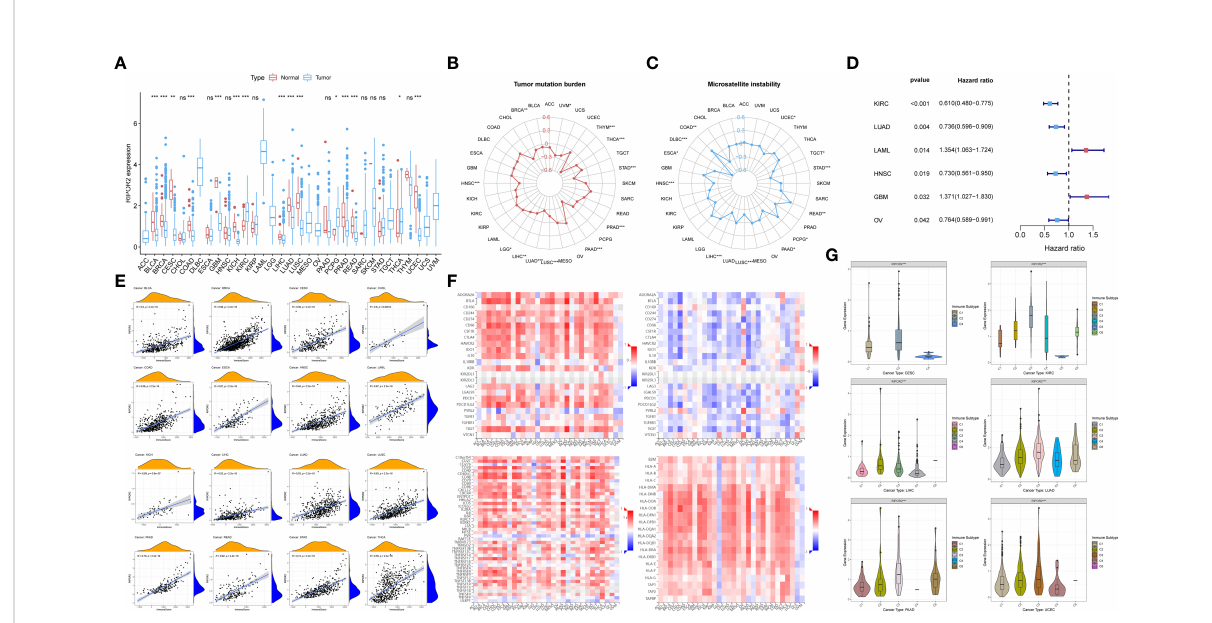
FIGURE 7 (A) The discrepant expression patterns of RIPOR2 in tumorous and normal samples were displayed (p-Value: *** p < 0.001, ** p < 0.01, * p < 0.05, ns p > 0.05). (B, C) The radar charts depicted the distributions of TMB (B) and microsatellite instability (MSI) (C) respectively. Corresponding to the circle representing value zero, the relative position of the points indicates the values of the index. (D) The forest plot showed the hazard ratios and p-values of how RIPOR2 affects the prognoses of various tumors. When RIPOR2 functions as a protective indicator, the pot gets drawn in blue when the risky factor is red. (E) We showed the results of correlation analyses in dot plots with R and p-values. The orange hill represents the distribution of immune-score and the blue hill of RIPOR2 expression. The positiveness of the relations can be seen from the rising fi tting line. (F) The grid heatmaps show the relations between RIPOR2 and ICPs with different functions in immune response, inhibitory ICPs on the top-left and the sub- fi gure on the top-right, in contrast with the association between the expression of methylated RIPOR2 distribution and the same ICPs. The stimulatory ICP group is in the bottom-left corner, and HLA-related genes are on the bottom-right. (G) The samples can be divided into six immune subtypes: C1 – C6 corresponding to Wound Healing, IFN- g Dominant, In fl ammatory, Lymphocyte Depleted, Immunologically Quiet, and TGF- b Dominant. The scattering situation was shown in boxplots. If any of the immune subtypes do not exist in a cancer species, they will not appear in the